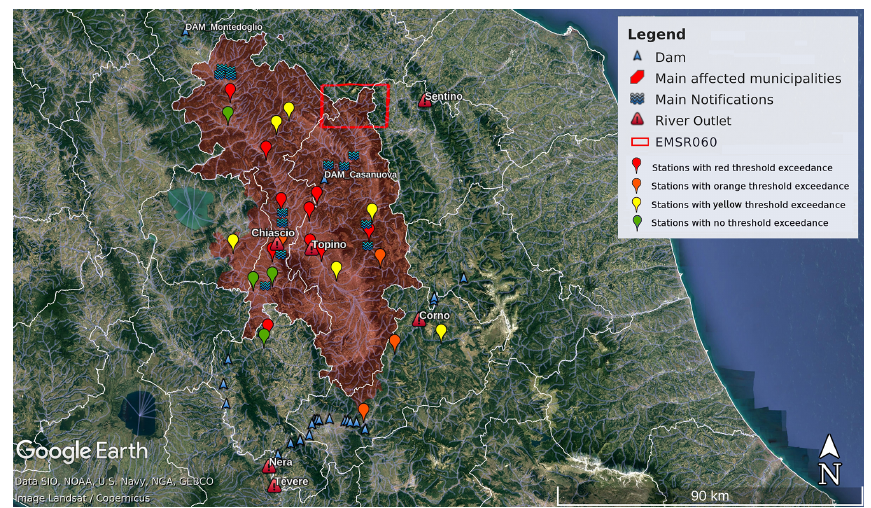
Figure 2. Geo-referred information of the ODB for CS01, Umbria region, with localization of main recorded floods (blue waves), hydrometric stations used for the indices’ validation (pinpoints). Red triangles indicate the position of outlets of the main rivers involved, while blue triangles indicate the presence of dams. Hydrometric station pinpoints are coloured according to the maximum hydrometric threshold reached during the event. Municipality areas affected by flooding are filled in red. The red rectangle represents the involved area published on the Copernicus Emergency Management Service platform (https://emergency.copernicus.eu/mapping/list-of-components/EMSR060, last